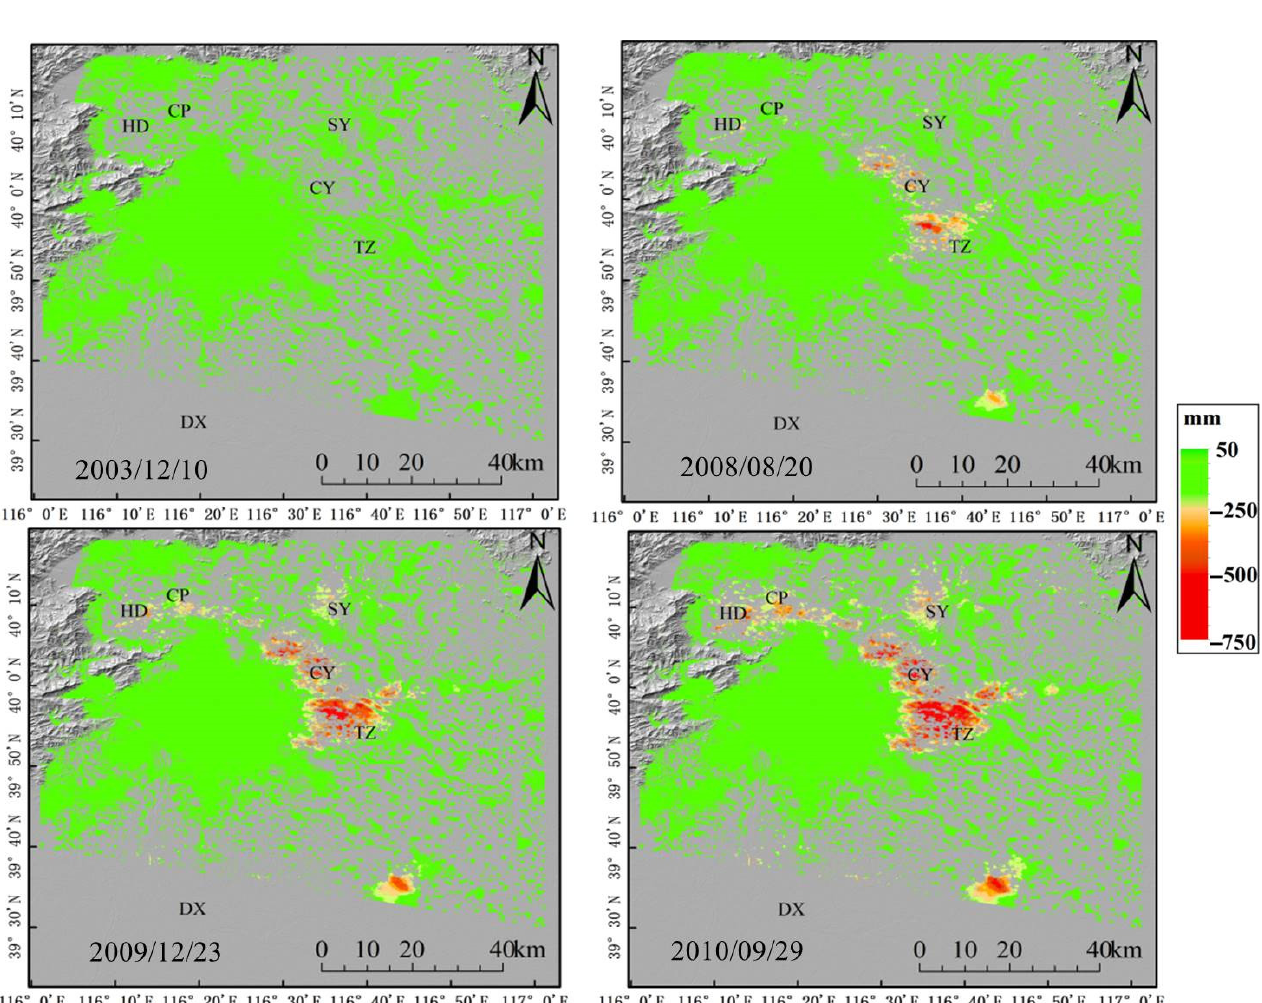
Figure A1. Cumulative time-series deformation in LOS from 2003 to 2010. CY: Chaoyang District, CP: Changping District, HD: Haidian District, SY: Shunyi District, and TZ: Tongzhou District.